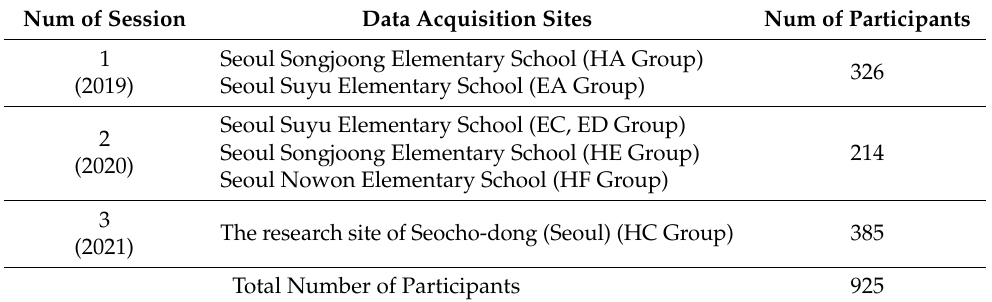
Table 1. Participants and data acquisition site for each